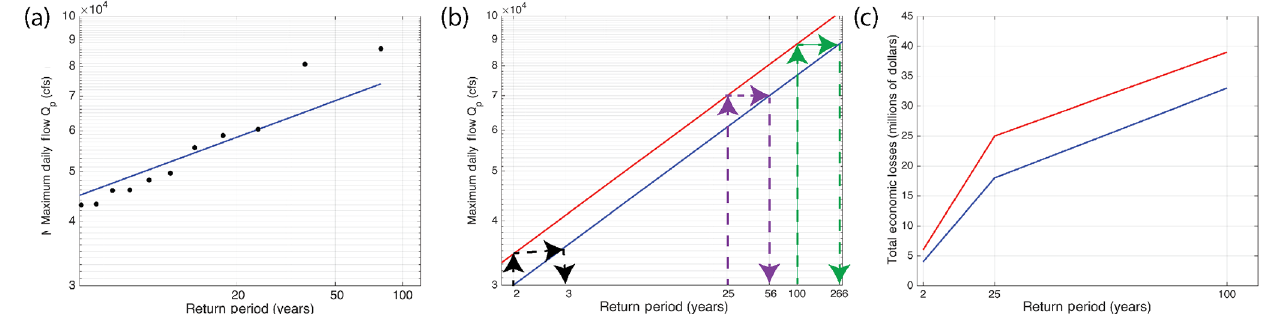
Figure 13. Methodology to calculate the historical and future expected annual losses using only HAZUS and streamflow observations. (a) Flow duration curve for the Porter gauge and the fitted lognormal distribution. (b) Fitted streamflow for different return periods for the historical period (blue) and the future (red). The changes in streamflow in the future are calculated by assuming a 15% increase in streamflow in the future. We then calculate the changes in return period. (c) Economic loss probability curve for the current and future